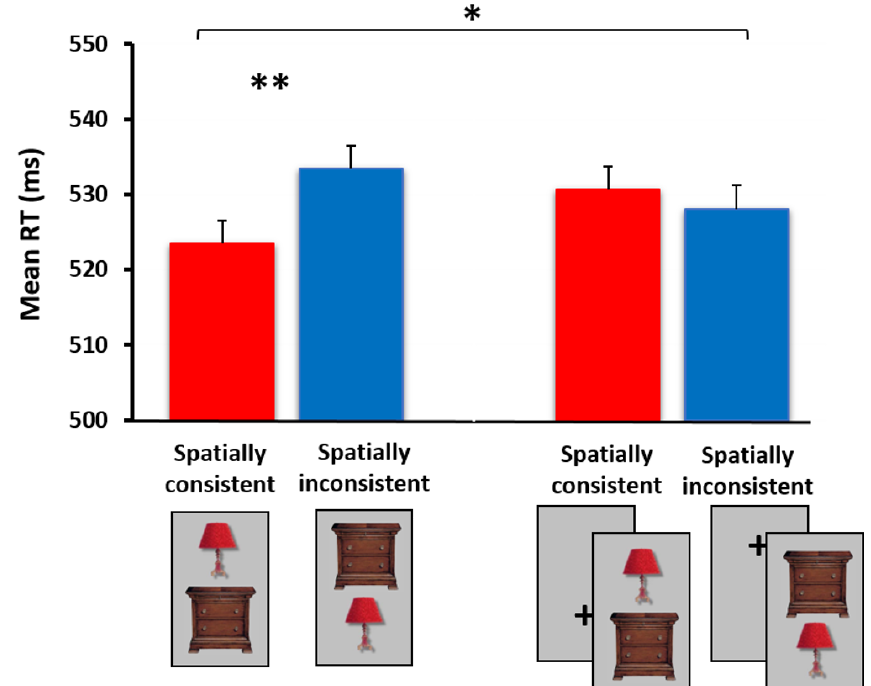
Figure 2. The spatial consistency effect among the nontarget stimuli in the basic experimental version (i.e., both stimuli are attended, left) vs. the spatial cuing experimental version (i.e., only one of two stimuli is fully attended and relevant to task requirements, right). The cross seen on the right served as a spatial cue, flashing immediately before stimuli’s appearance, either in an upper (50%) or a lower location. In order to validate the spatial cuing manipulation, an additional condition (not shown here) was added to the experiment, including a single object—either cued or uncued—on which the stimulus classification task was performed. Obtaining faster RTs to the cued items assured that participants indeed responded to the spatial cue and shifted their visual attention to the cued location. Standard errors presented on top of the bars were computed for the difference RT scores (i.e., spatially inconsistent—consistent, see, e.g., [106]) within each experiment. A statistically significant between-subject interaction was obtained when comparing the results of the two experiments (N = 20 in each). * p < 0.05, ** p < 0.01. The full results are published in